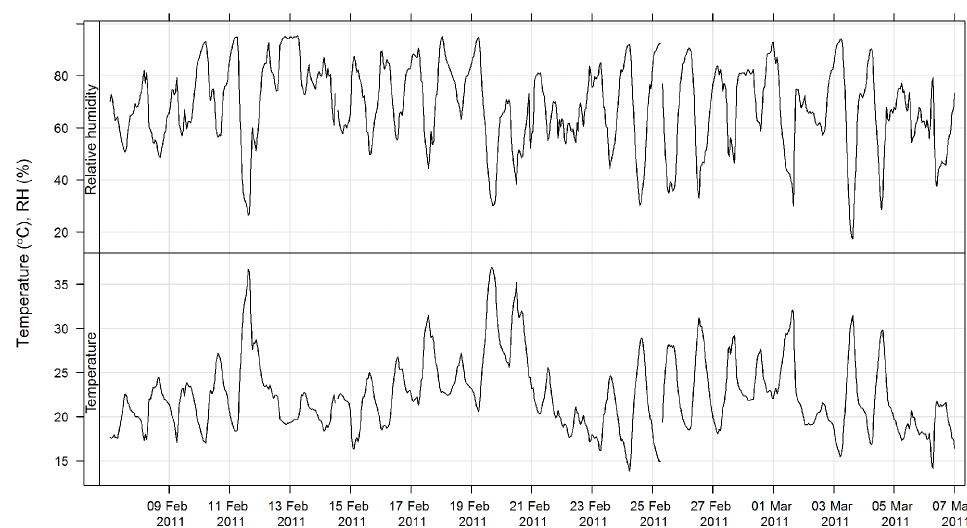
Figure 9. Time series of ambient temperature and relative humidity during SPS-I.